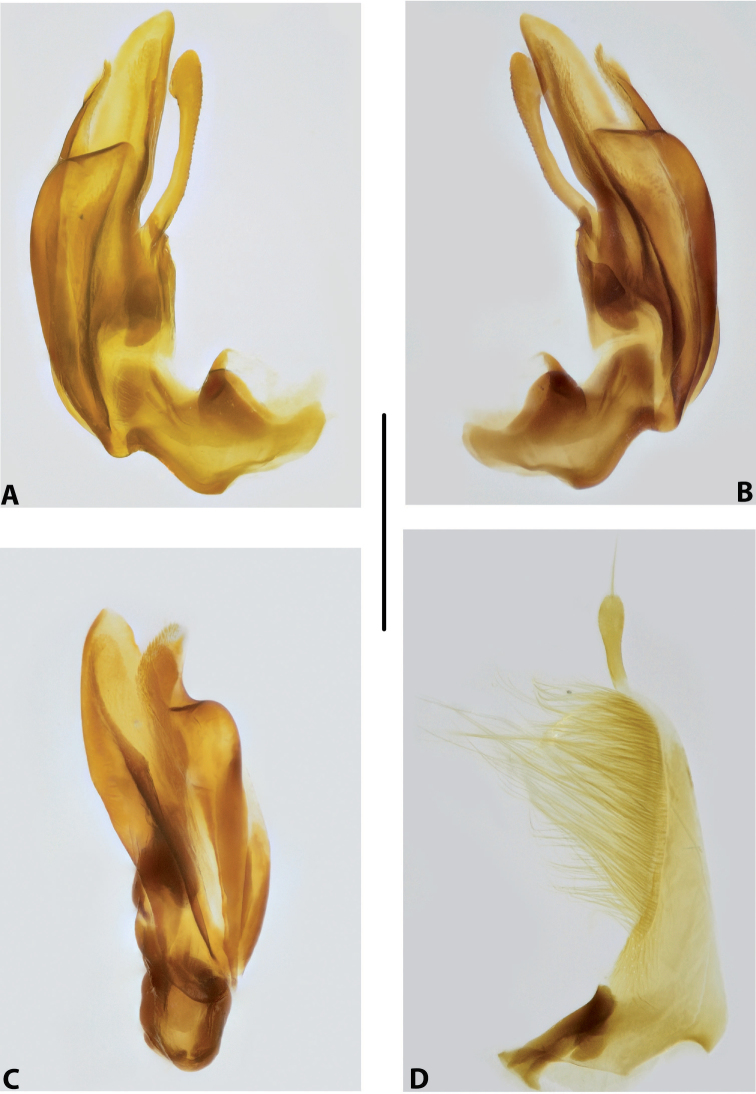
Copelatus
daemeliA median lobe in lateral view, right side B median lobe in lateral view, left side C median lobe in ventral view D left paramere in external view. Scale bar: 0.5 mm.